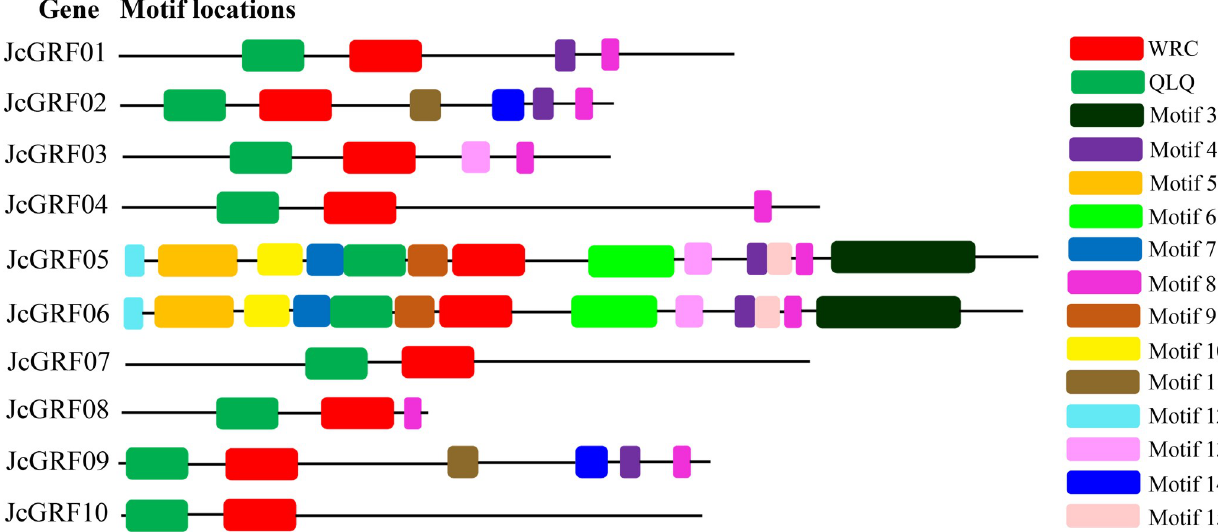
Fig 3. Conserved motifs of JcGRF protein obtained by MEME analysis. Different colored boxes represented different motifs, and were displayed on the right.